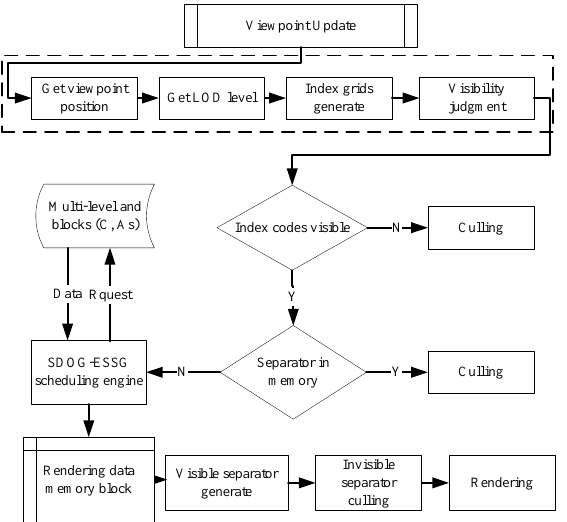
Figure 8. Dynamic scheduling based on multi-hierarchical and multi-blocks scheme Algorithm 2 Procedures of dynamic scheduling based on multi-hierarchical and multi-blocks